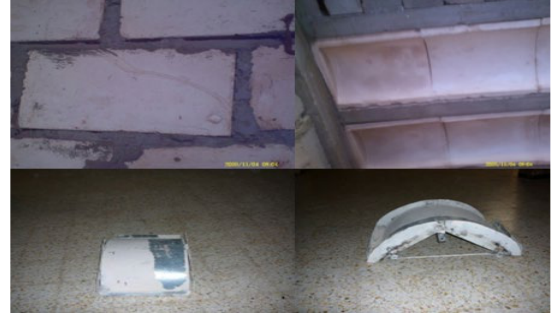
Figure 1. The use of gypsum blocks for the ceiling and walls in the city of